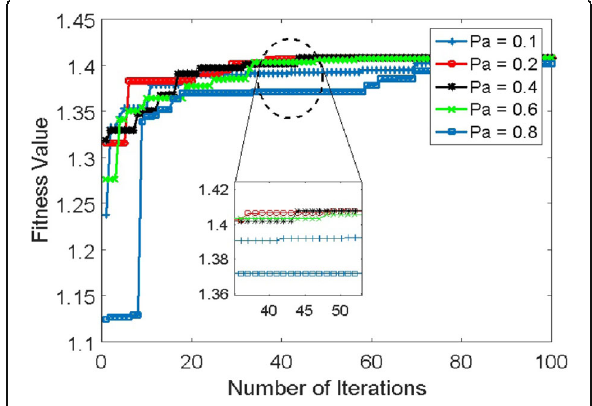
Fig. 1 Choice of CSO parameter